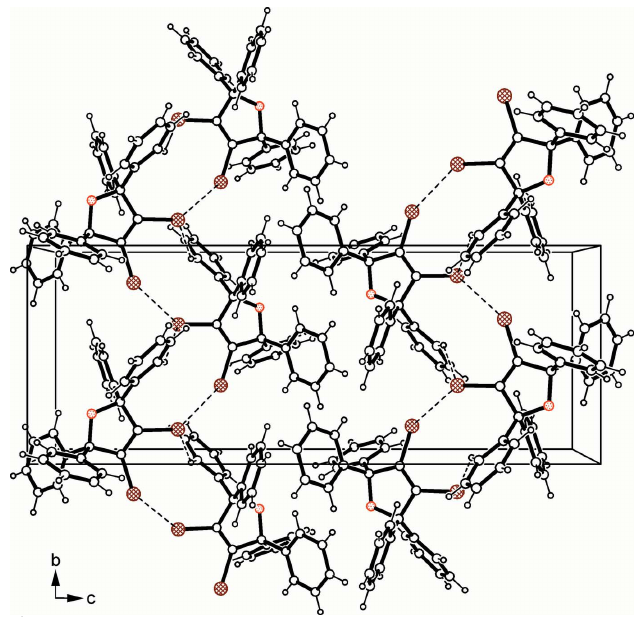
Figure 2 Part of the packing of the title compound viewed along the a -axis. Oxygen atoms are displayed as dotted circles (red) and bromine atoms as cross- hatched circles. The intermolecular contacts are shown as dashed lines.